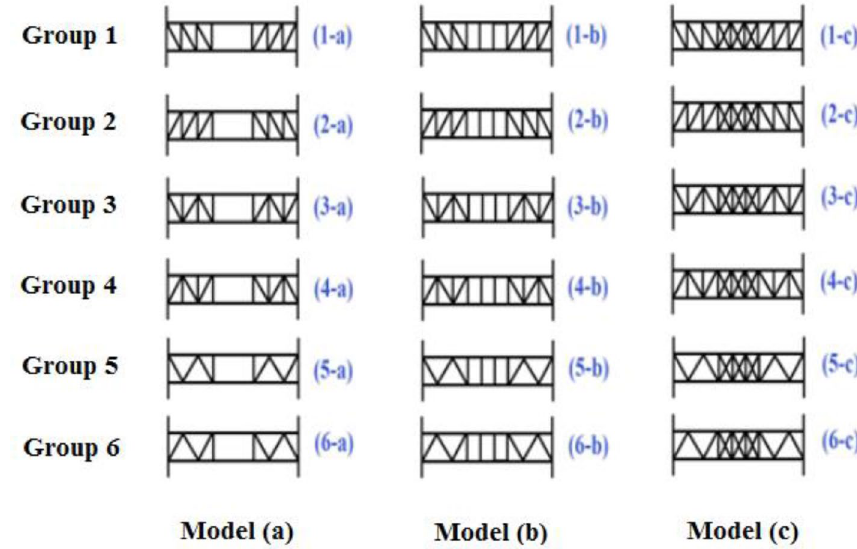
Fig. 4 Geometric arrange- ments of the studied